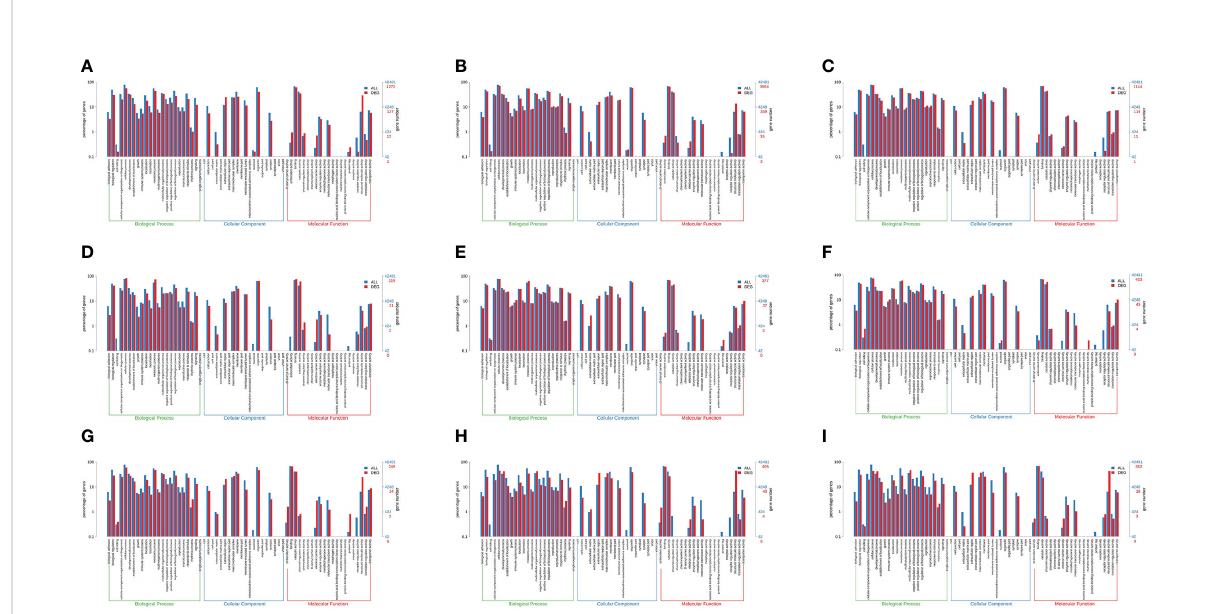
FIGURE 8 Results of the enrichment analysis of the gene ontology (GO) terms of DEGs in the gills (A, B, C) , hepatopancreas (D, E, F) , and muscle (G, H, I) of M. nipponense exposed to different salinity gradients, respectively.